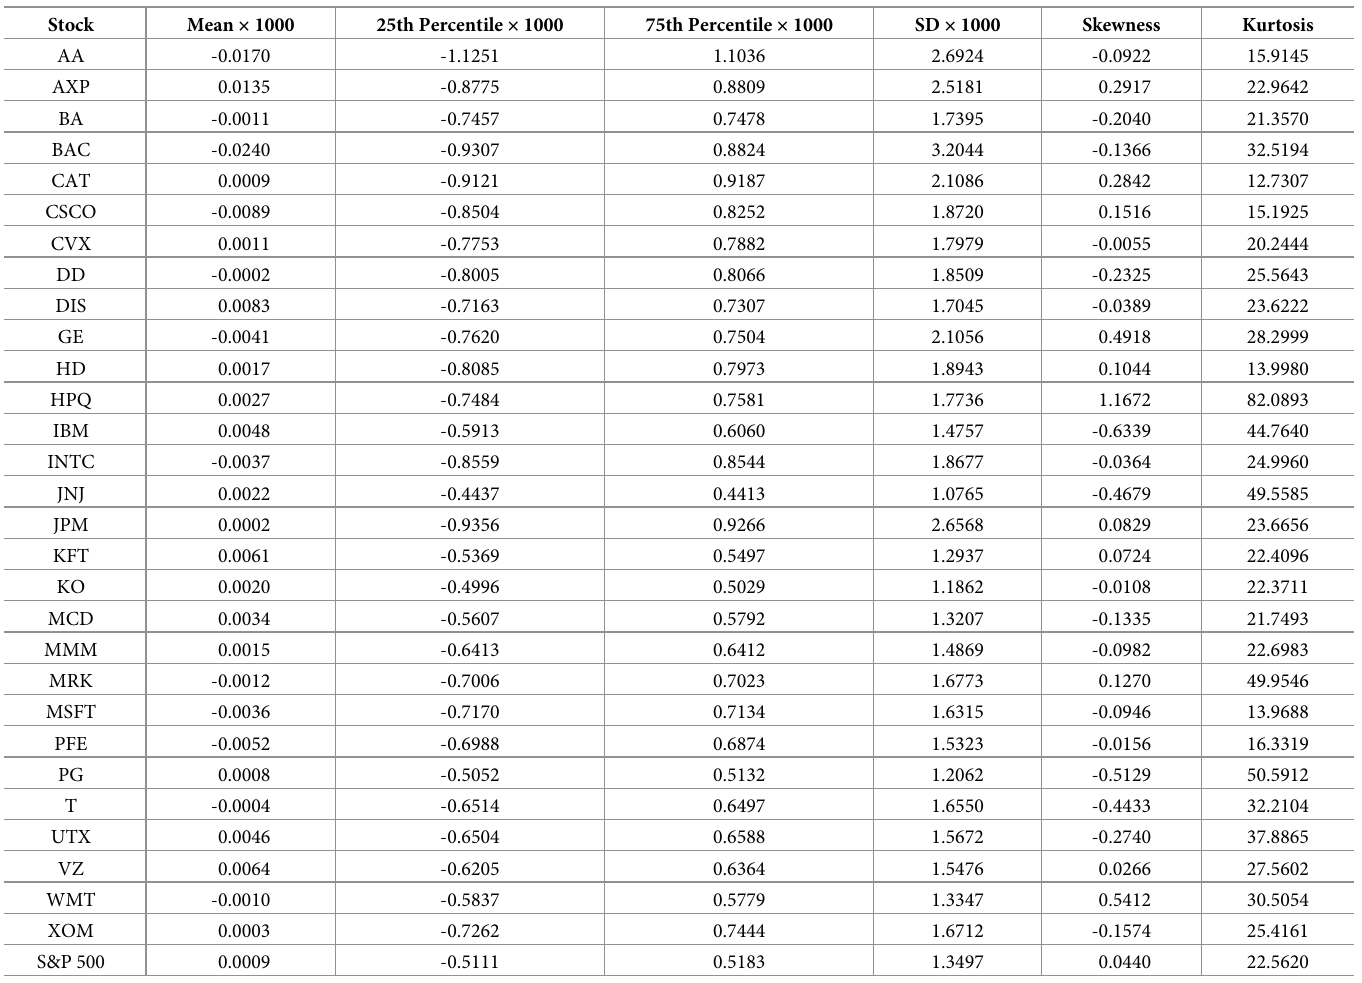
Table 3. Descriptive statistics for 5-min